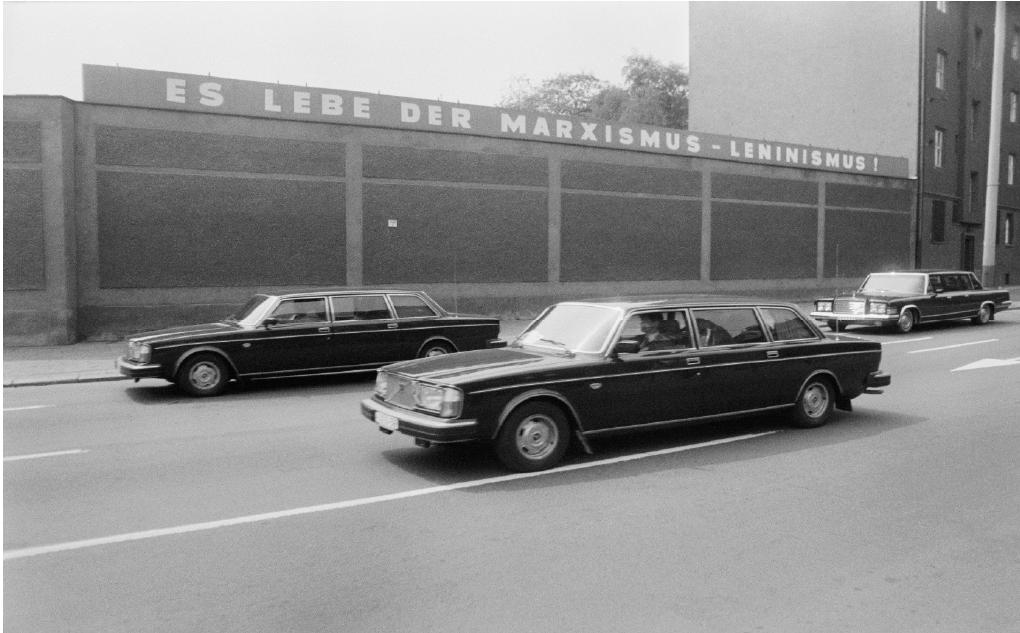
Figure 5. Harald Hauswald, Regierungskonvoi, Wilhem-Pieck-Straße, Berlin-Mitte (Governmental convoy, Wilhem-Pieck-Straße, Berlin-Mitte), from the series Everyday Life , 1980. Photo Credits: Ostkreuz–Agentur der Fotografen/Harald Hauswald.